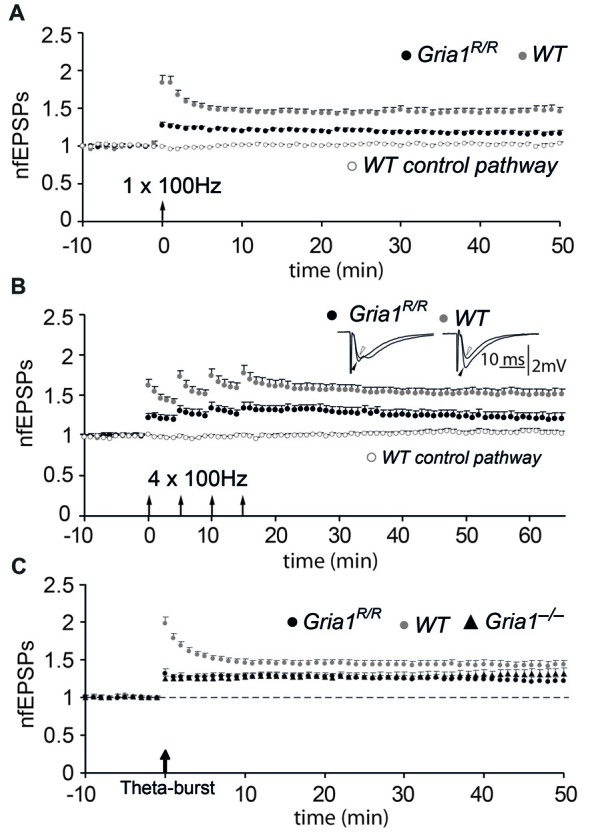
Diminished long-term potentiation (LTP) in Gria1R/R mice. (A) Normalized and pooled fEPSP slopes evoked in str. radiatum at CA3-to-CA1 synapses in slices from Gria1R/R and WT mice. LTP was induced by a single tetanization. For the sake of clarity, only the non-tetanized control pathway in control WT mice is shown. Arrow at the abscissa indicates the time of tetanic stimulation. Vertical bars indicate SEM. (B) As in (A), but four tetanizations were used for LTP induction. Insets show means of six consecutive synaptic responses in the tetanized pathway before (open arrowhead) and 45 min after (filled arrowhead) tetanization in an experiment from a Gria1R/R (left sweeps) and a WT (right sweeps) control. (C) As in (A), but LTP was induced by a theta-burst paradigm where synaptically and antidromically evoked responses were paired. For comparison, experiments performed in slices from the brains of Gria1−/− mice are also shown.